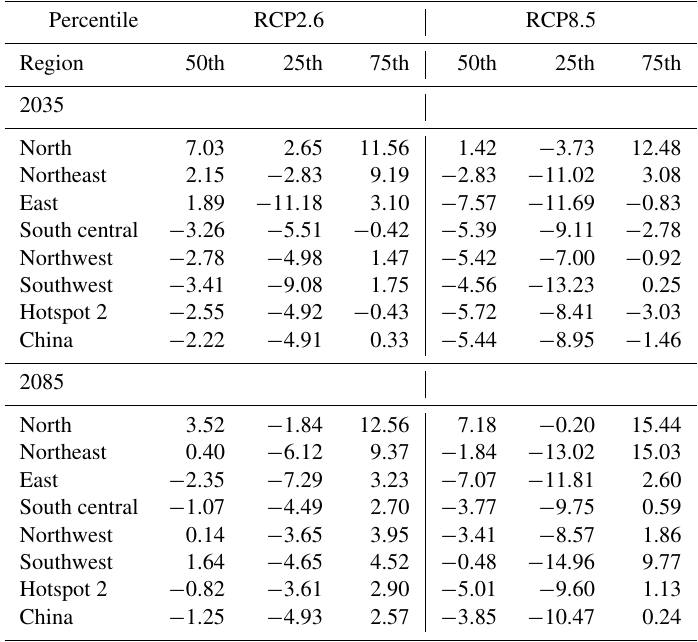
Table 2. Percentiles of annual DHP changes (%) for regions in China over 2020–2050 (2035) and 2070–2099 (2085) across the ensemble of GCM-GHM